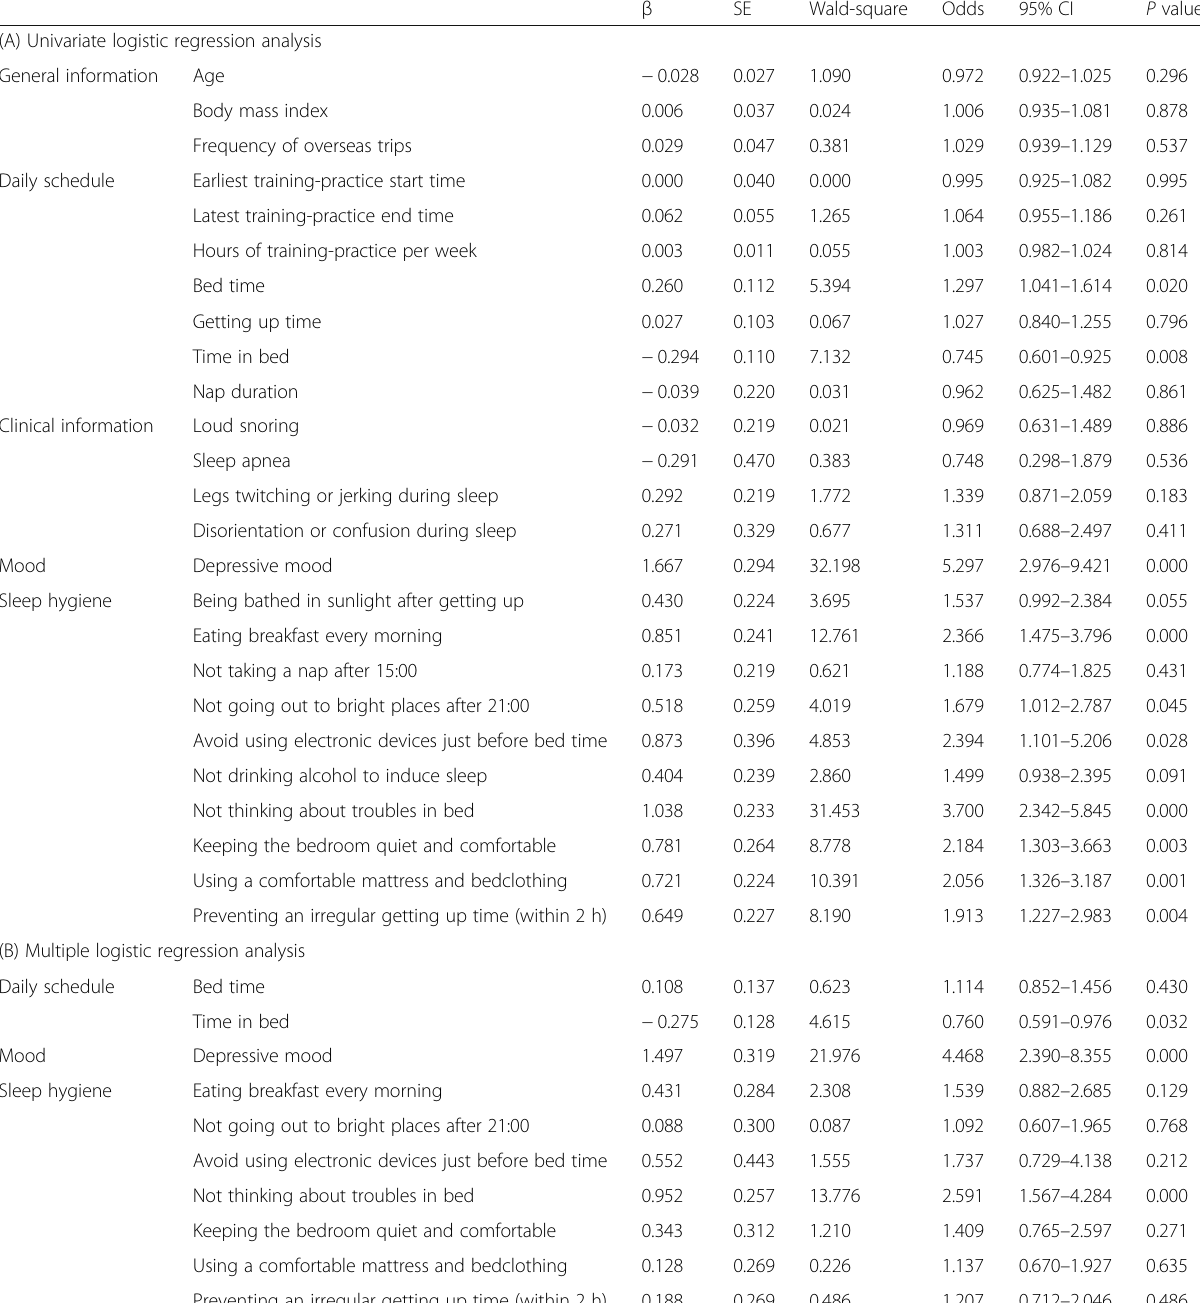
Table 6 The associations amongst sex, age, body mass index, experience of overseas trips, training-practice schedule, depressive mood and sleep habits, and poor sleep quality (PSQI global score > 5.5) in males β SE Wald-square Odds 95% CI P